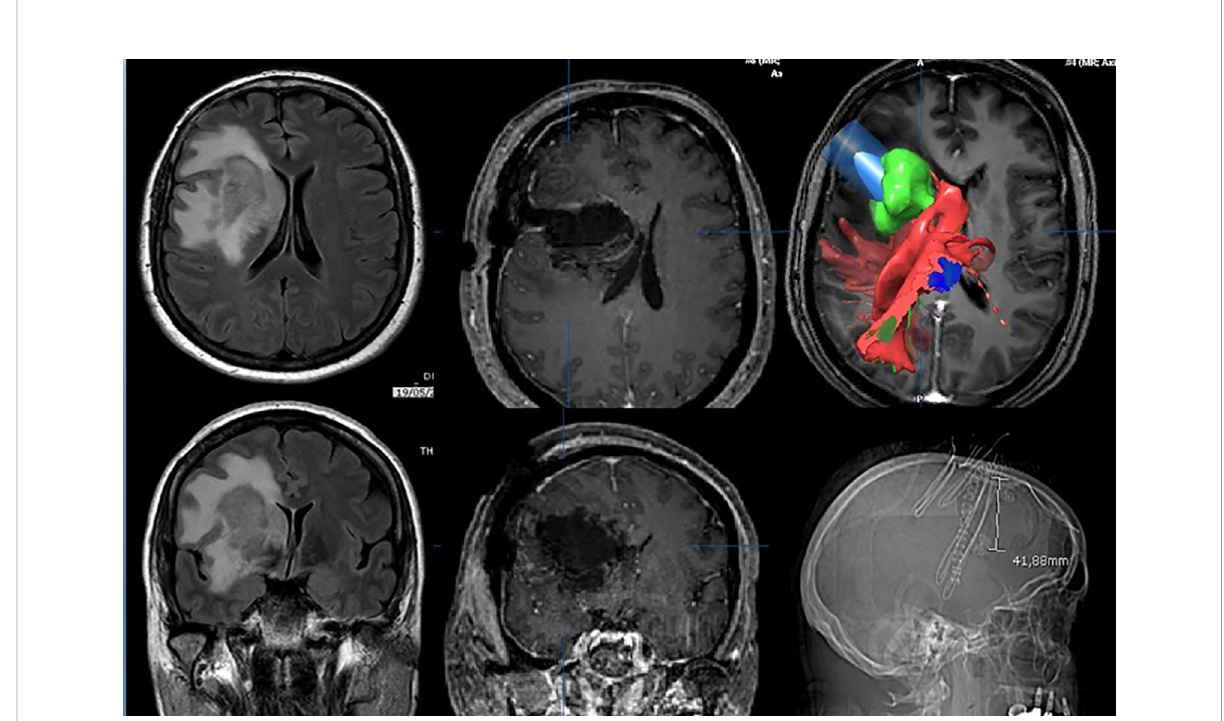
FIGURE 3 Fronto-opercular approach to an insular high-grade glioma targeted according DTI and